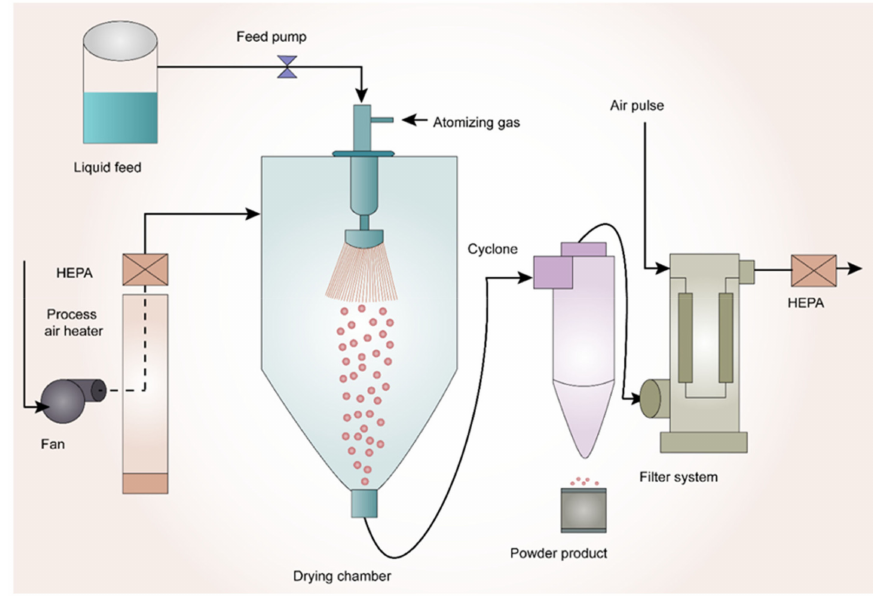
Figure 2. Schematic Representation of Spray-Drying